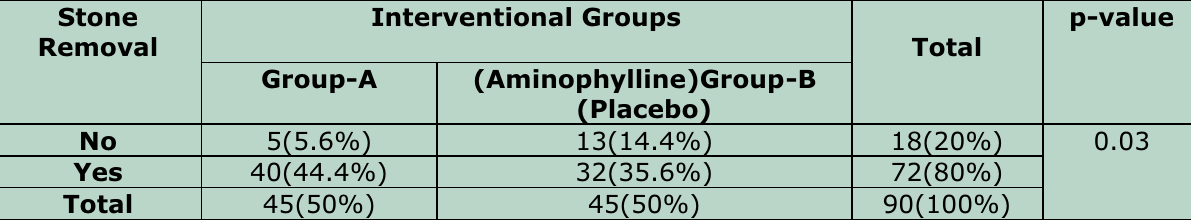
Table-III: Comparison of stone removal in interventional and placebo group.